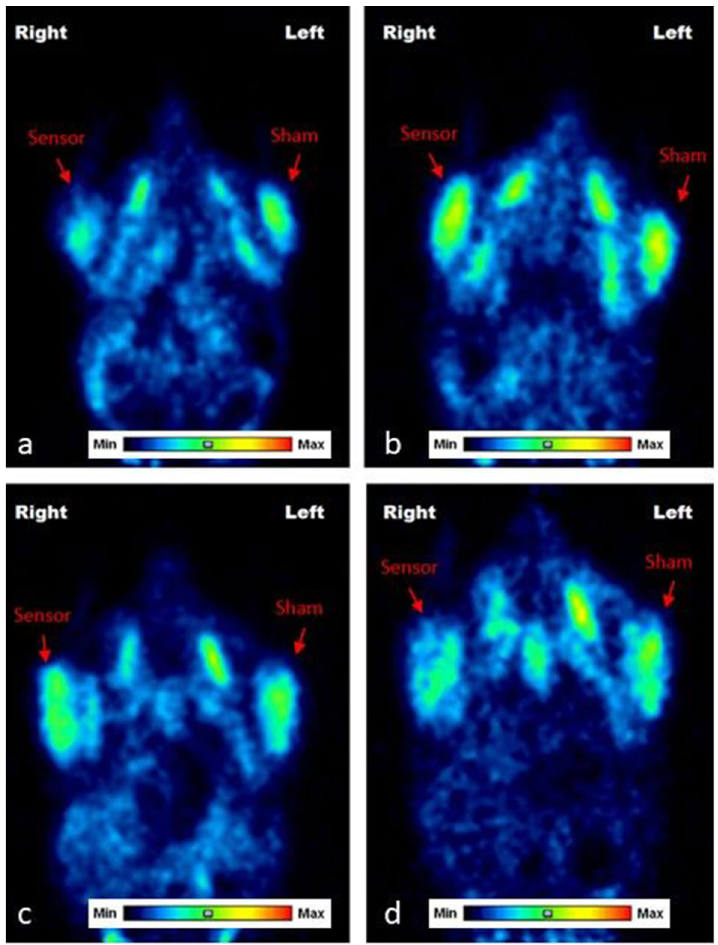
Figure 2. Representative PET images illustrating FDG imaging characteristics in a rat injected with Printex oxygen sensor in the right gastrocnemius muscle and sham injection in the left one. The PET images were acquired at ( a ) 4 days, ( b ) 47 days, ( c ) 97 days, and ( d ) 181 days. Images were normalized to a common background intensity. Each image is an independent activity-level range with the same intensity of